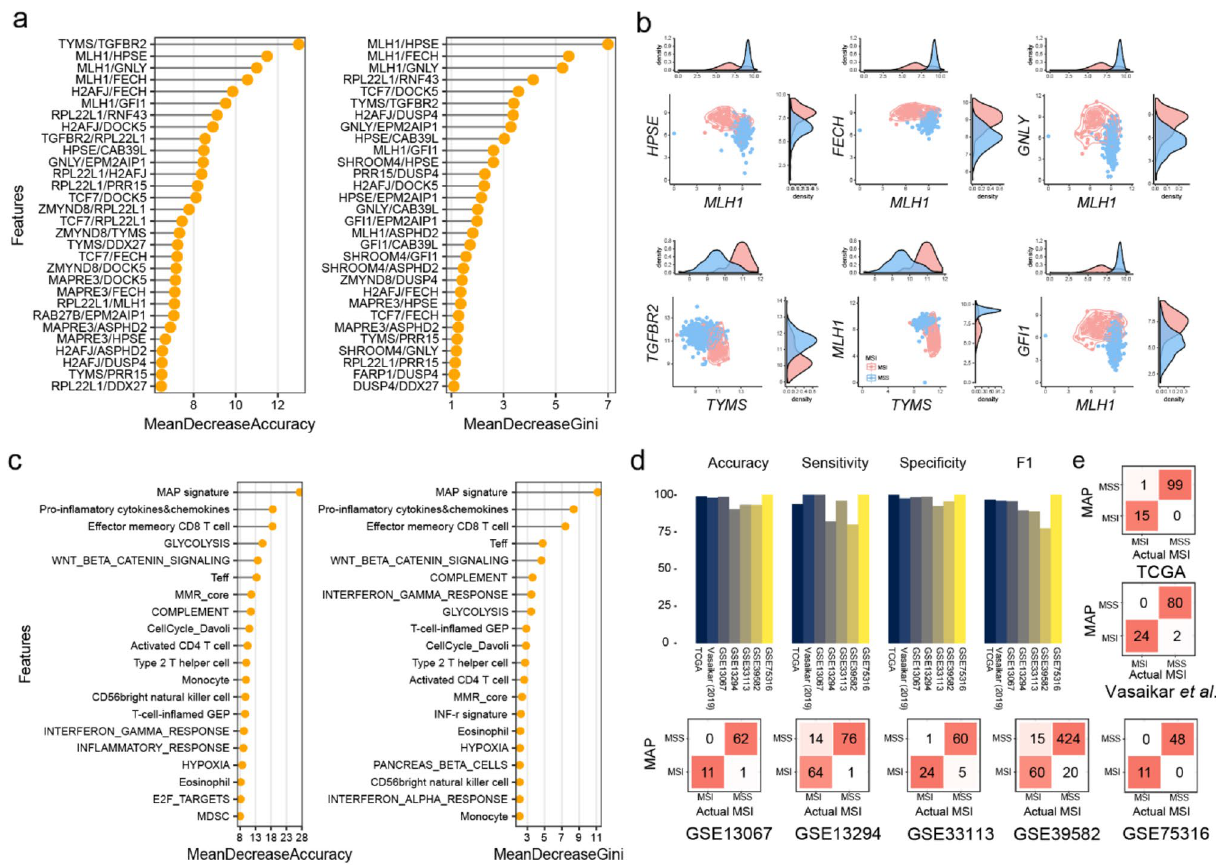
Figure 2. MAP model. ( a ) Top 30 important features of the MAPpairs model. The mean decrease in accuracy (left) is a measure of how much influence a feature has in improving classification accuracy. The mean decrease in Gini (right) is a measure of how impurity can be reduced by features used when separating nodes. ( b ) A scatter plot and histogram of the gene pairs. The relationship between the expression of two genes in the MSI and MSS groups can be confirmed through a scatter plot, and the expression value of each gene can be confirmed through the density plots at the upper and lower right corners. MLH1 -related rules and TFGBR2/ TYMS rule are shown. ( c ) Top 20 important features (signatures) of the MAPsig model. ( d ) Performance (accuracy, sensitive, specificity, and F1) of the MAP model. ( e ) Confusion matrices of the validation dataset. The actual MSI means MSI status provided in the dataset study. The red color-scale reflects percentages of class predictions against the actual